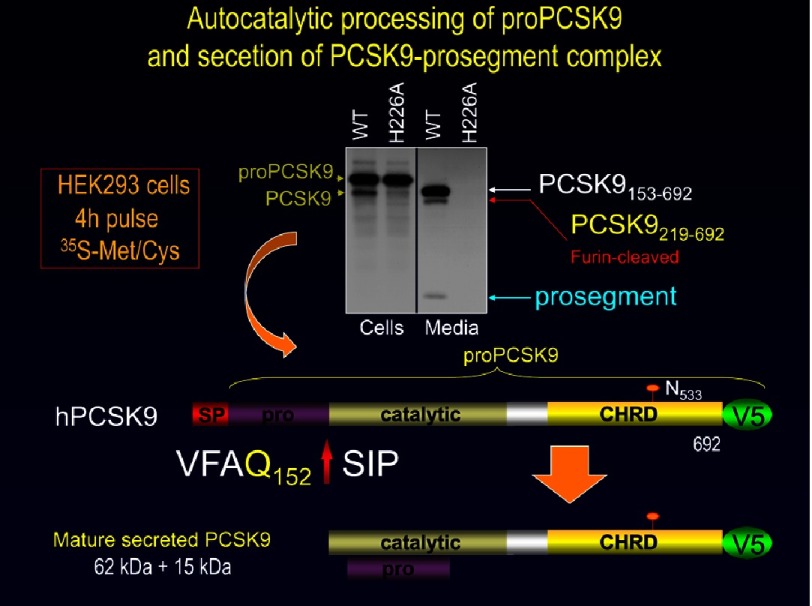
Biosynthesis of PCSK9 in HK293 cells.The V5-tagged PCSK9 or its active site mutant H226A were transiently expressed in HEK293 cells. The next day the cells were pulse-labeled with [35S]Met/Cys for 4 h. Cell extracts (C) and media (M) were immunoprecipitated with a V5 antibody and the precipitates were resolved by SDS/PAGE on an 8% tricine gel. The migration positions of molecular mass standards (kDa), proPCSK9, PCSK9 and the prosegment are emphasized, together with the Furin cleaved product observed. Note that the active site mutant is neither cleaved not secreted, emphasizing the necessity of prodomain autocatalytic cleavage for PCSK9 to exit the ER and be secreted.